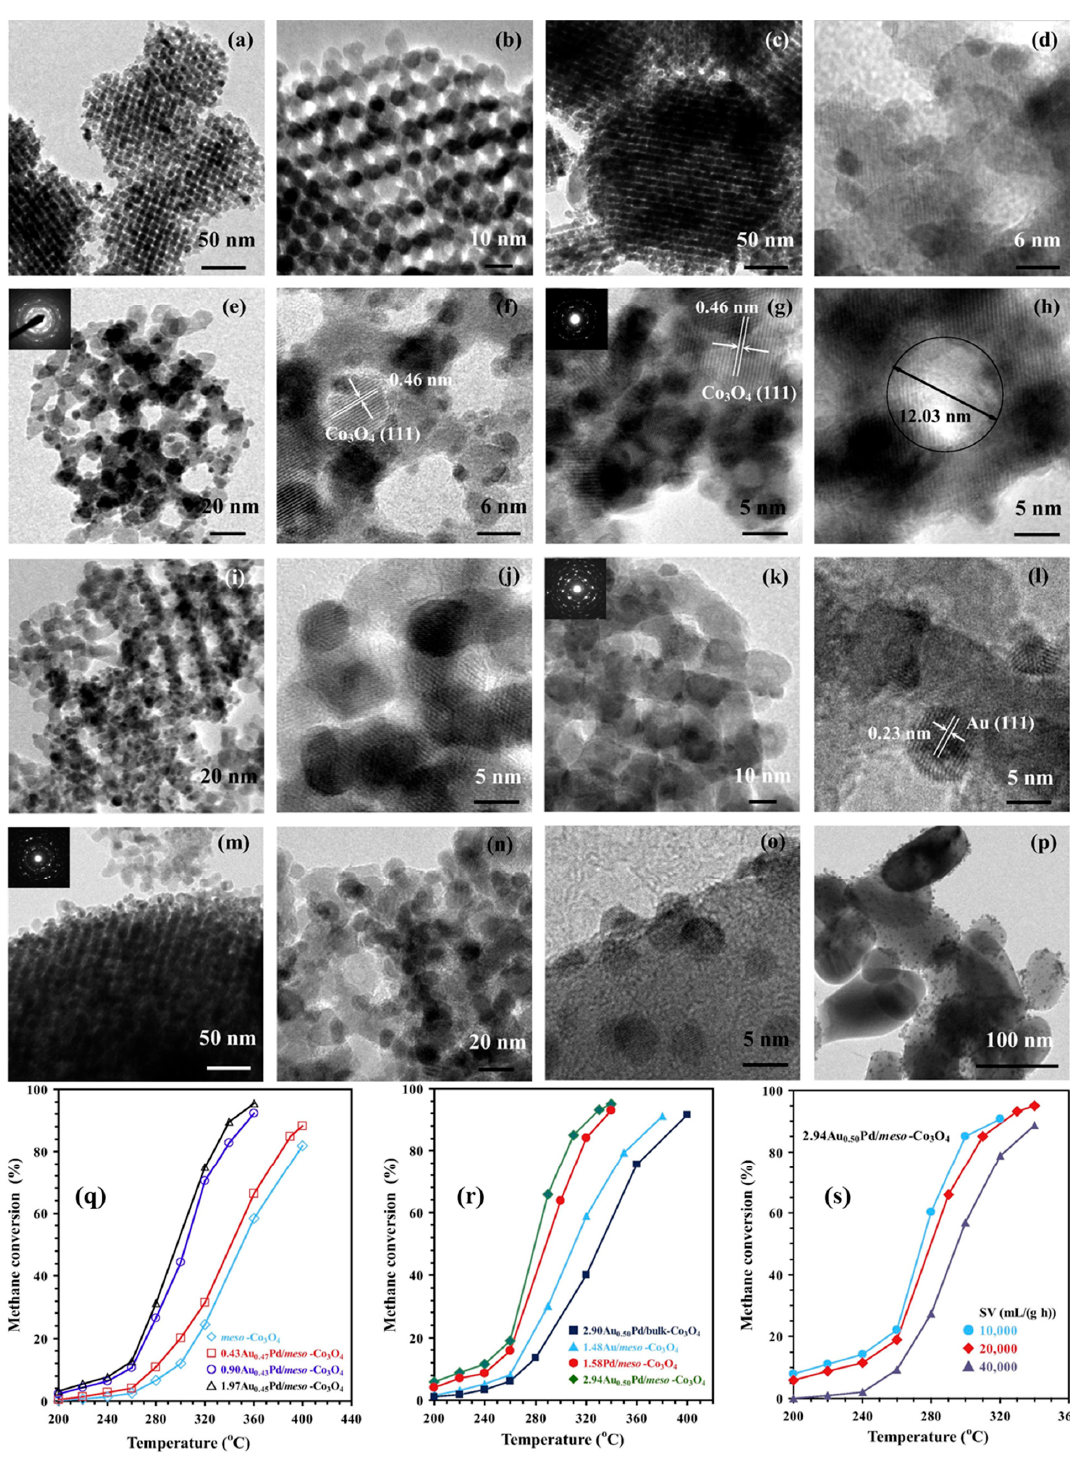
Figure 4. TEM images and SAED patterns (insets) of ( a , b ) meso - Co 3 O 4 , ( c , d ) 0.43Au 0.47 Pd/meso - Co 3 O 4 , ( e , f ) 0.90Au 0.43 Pd//meso - Co 3 O 4 , ( g , h ) 1.97Au 0.45 Pd/meso - Co 3 O 4 , ( i , j ) 2.94Au 0.50 Pd/meso - Co 3 O 4 , and ( k , l ) 1.48Au/meso - Co 3 O 4 , ( m , n ) 1.58Pd/meso - Co 3 O 4 , and ( o , p ) 2.90Au 0.50 Pd/bulk- Co 3 O 4 ; ( q , r ) methane conversion as a function of reaction temperature over the as-prepared samples at SV = 20,000 mL/(g h); and ( s ) effect of SV on methane oxidation over the 2.94Au 0.50 Pd/meso - Co 3 O 4 sample. Reprinted with permission from Ref. [28]. Copyright 2015, copyright Elsevier